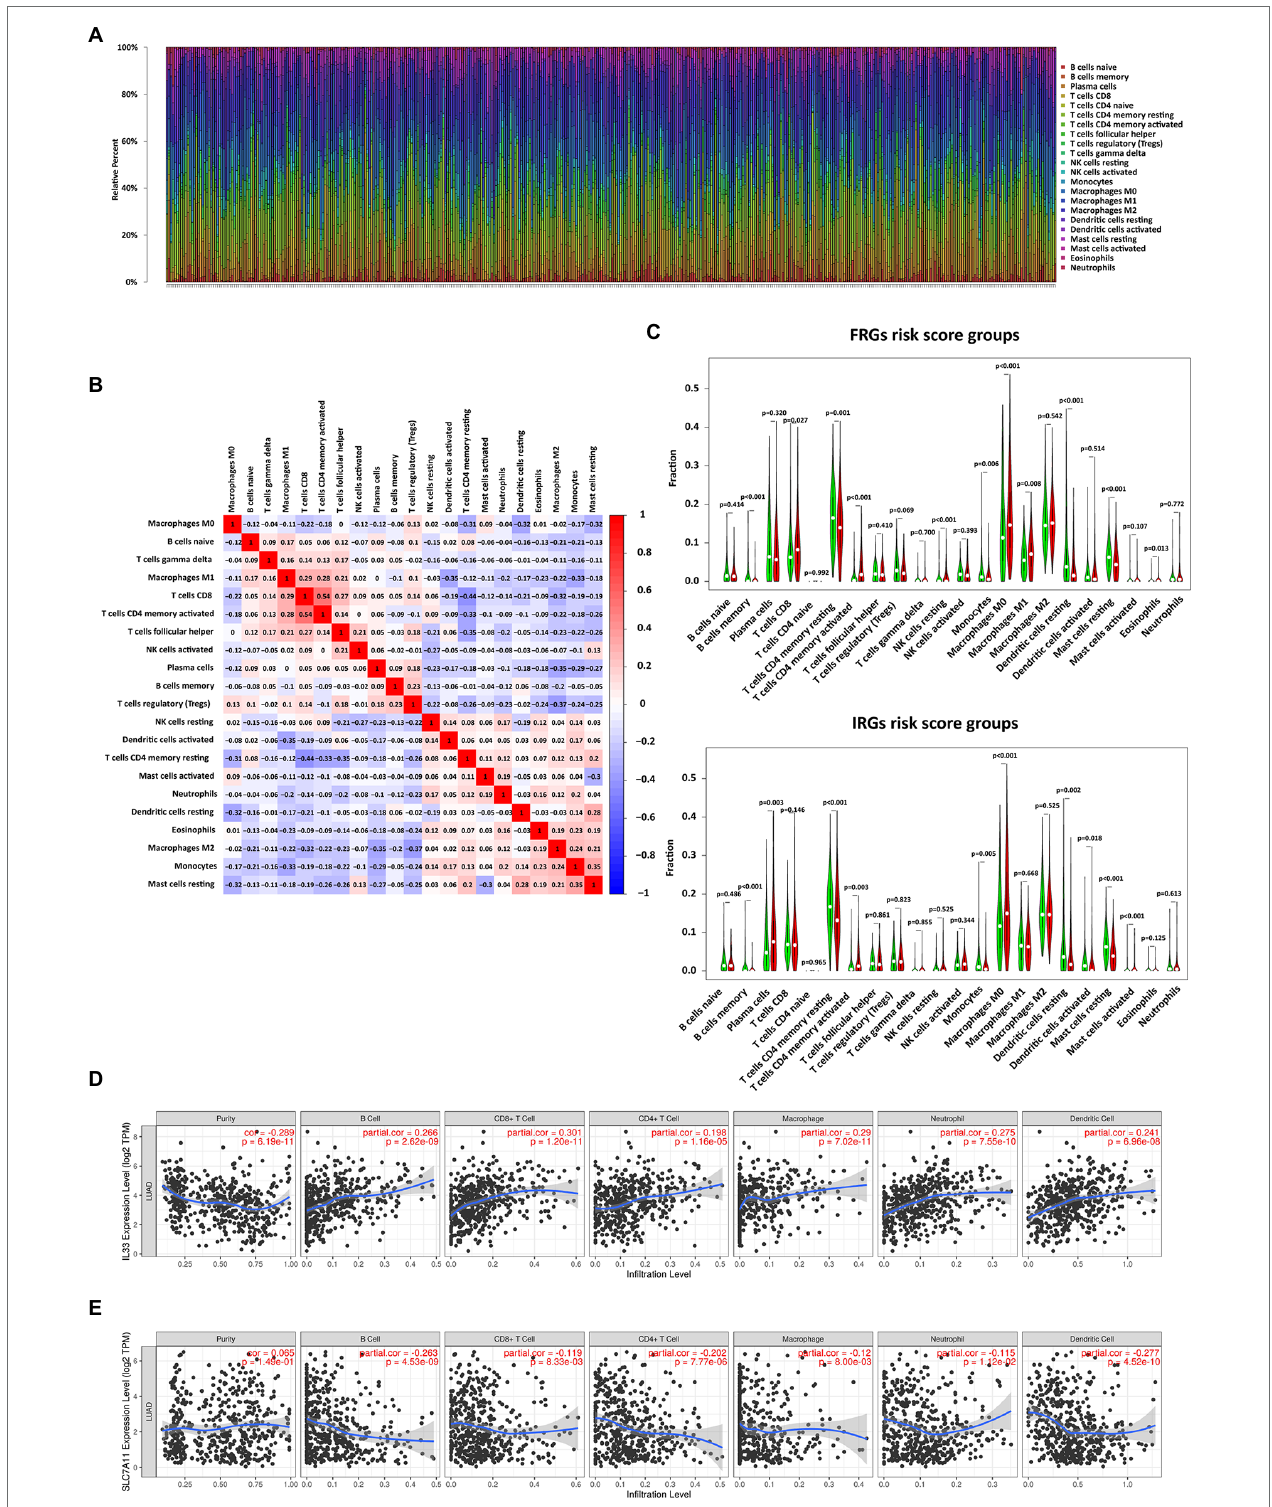
FIGURE 5 | Correlation analysis of immune cell infiltration with risk scores and expression of FRGs. (A) The bar chart shows the distribution of 22 types of immune cells in each sample. (B) Correlation matrix of immune cell proportions. (C) Violin plots of the differentially infiltrated immune cells between the low- and high-risk groups. (D) The correlation between IL33 expression and infiltration of immune cell subtypes. (E) The correlation between SLC7A11 expression and infiltration of immune cell